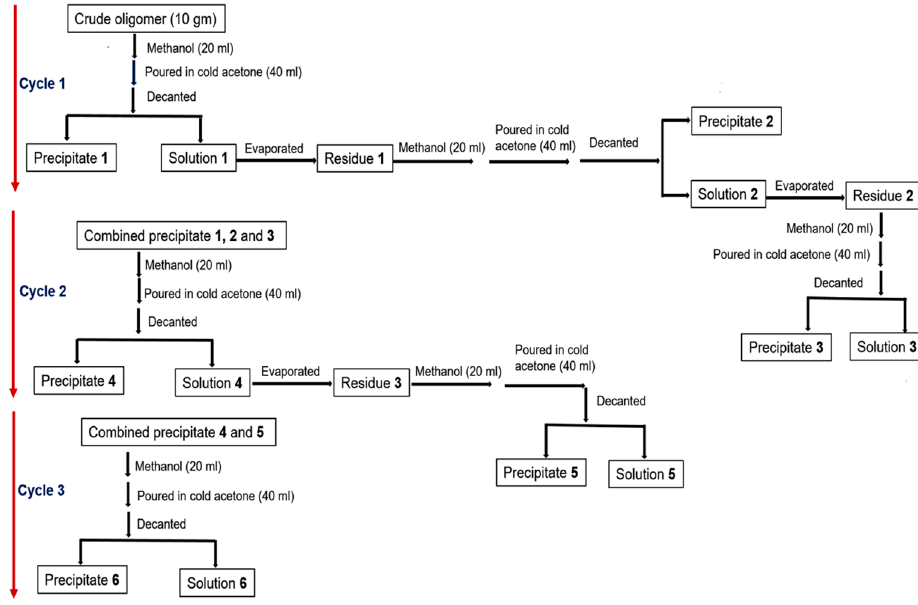
Figure 6. Iterative purification protocol for the separation of smaller oligomers from the product